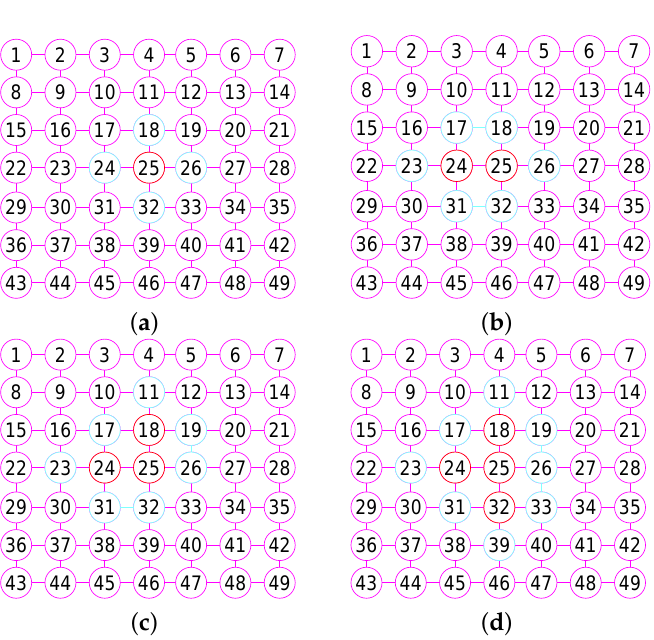
Figure 4. The 1-neighborhood subgraphs for the different nodes sets of the 7 × 7 grid graph G 7,7 . ( a ) A graph G and the 1-neighborhood subgraph N ( 25 ) of the node 25; ( b ) The 1-neighborhood subgraph of the nodes set S 1 = { 24,25 } ; ( c ) The 1-neighborhood subgraph of the nodes set S 2 = { 24,25,18 } ; ( d ) The 1-neighborhood subgraph of the nodes set S 3 = { 24,25,18,32 }